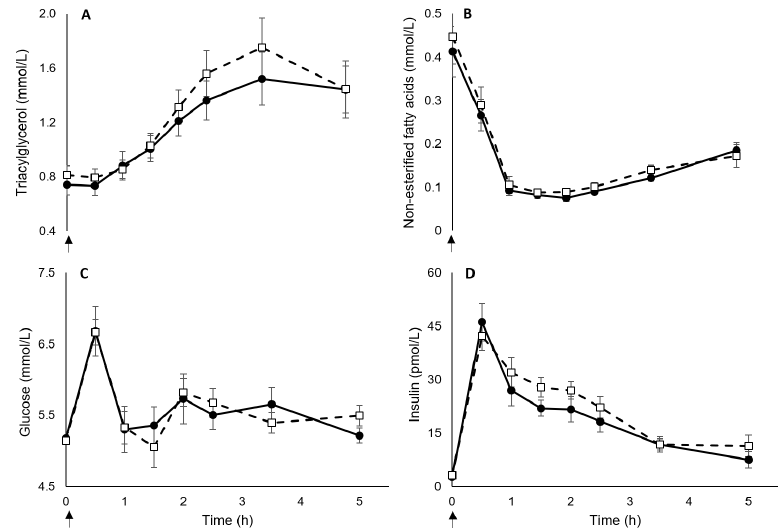
Figure 2. Triacylglycerol ( A ), non-esterified fatty acids ( B ), glucose ( C ), and insulin ( D ) concentrations in AAs ( n = 12) and TTs ( n = 12) during the five-hour trial (AAs: Solid lines and filled circles; TTs: dashed lines and unfilled squares). Arrow represents point of standardized meal provision. Data are represented as mean ± standard error of mean (SEM). Abbreviations: h, hour. No statistical between-genotype differences in time-averaged TG TAUC (mean difference: −0.10 mmol/L/h; 95% CI −0.52 to 0.31 mmol/L/h; p = 0.606; ES = 0.22) and NEFA TAUC (mean difference: −0.01 mmol/L/h; 95% CI −0.04 to 0.03 mmol/L/h; p = 0.734; ES = 0.15) were seen (Figure 3). Genotype